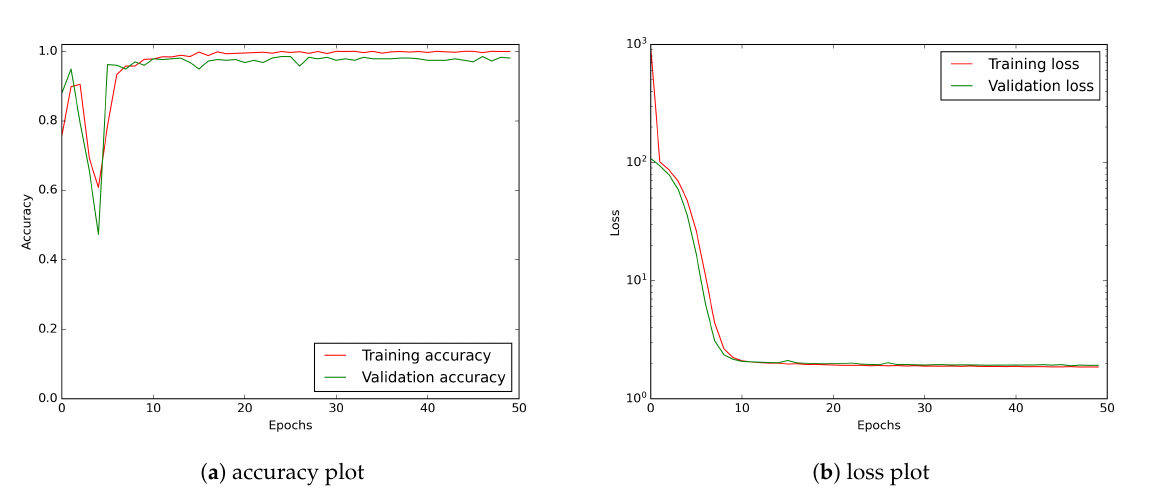
Figure 12. The exemplary of CNN model learning history for input tensor consisting of D2:D20 wavelets: ( a ) accuracy plot, ( b ) loss curve. A logarithmic scale has been applied to the loss plot to keep a better